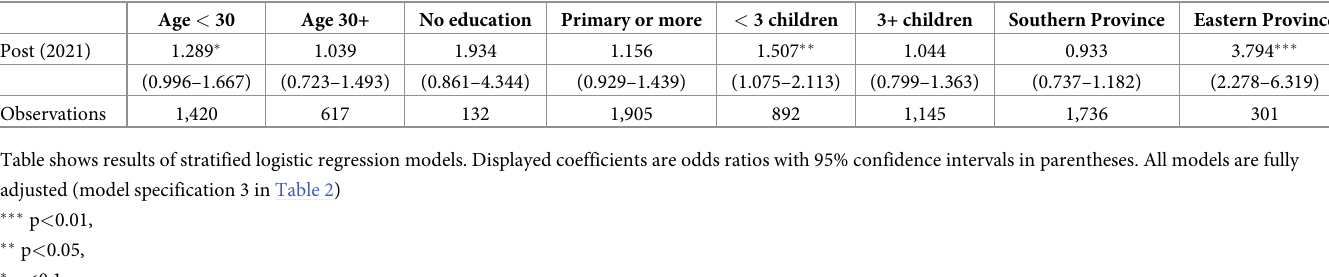
Table 3. Change in mental health distress by subgroup (stratified results).